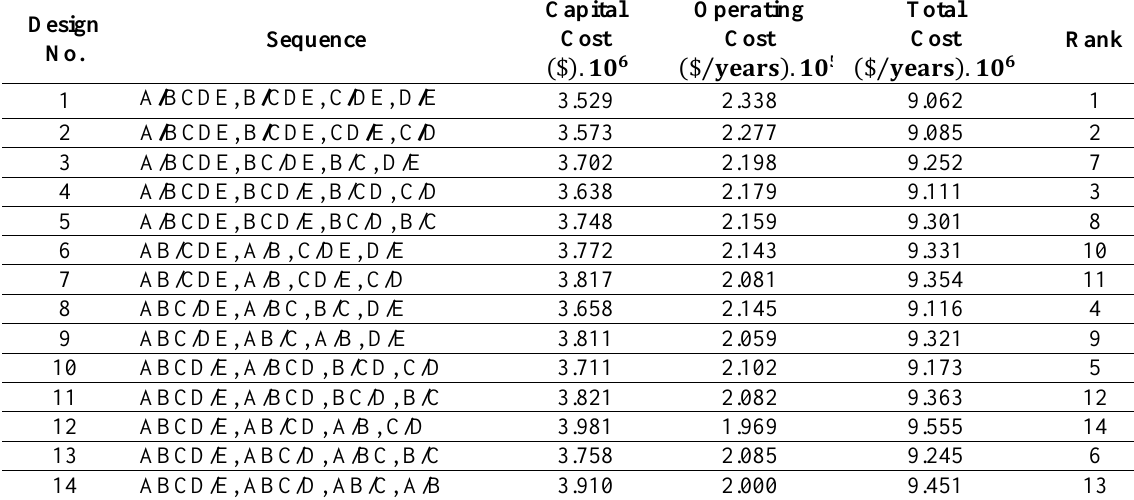
Table 4. Designing all of the feasible column sequences at 5 bar and have been ranked based on Total Annual Cost (TAC) as an object function.